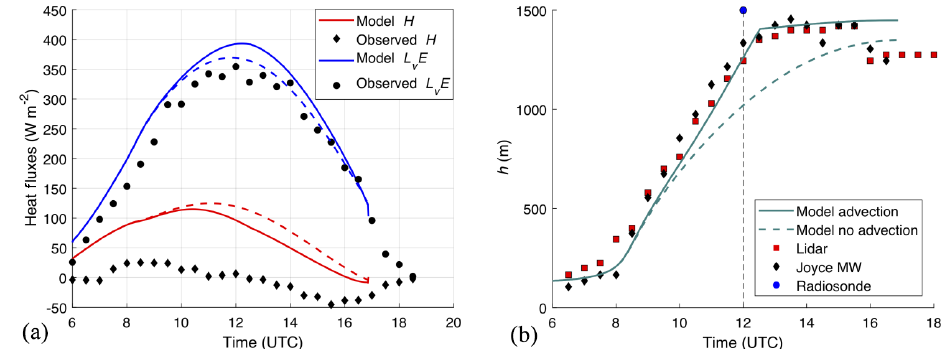
Figure 16. Comparison of the model and observed results of 7 May 2018: (a) surface fluxes and (b) boundary layer depth. The regional H , an aggregate that combines the vegetated and bare soil surfaces around the CloudRoots site as shown in Fig. 1b, is also included. For the boundary layer depth estimations, we used three different observational techniques. The lidar and microwave (MW) techniques were located at the JOYCE site facility. Solid and dashed lines represent the model results of surface fluxes and boundary layer height with and without imposing the advection of heat, respectively (Table A2), for completing the information on initial and boundary